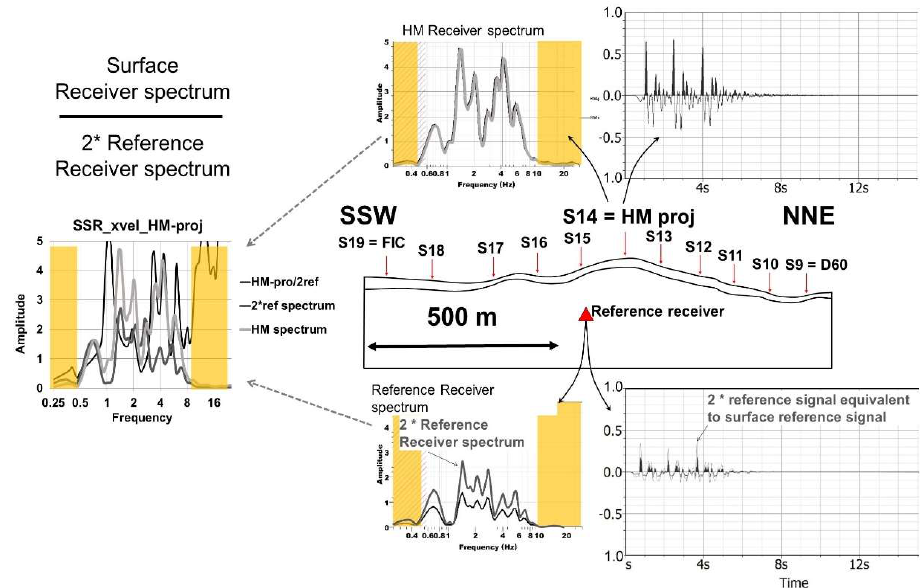
Figure 7. Processing of the modelled site response in terms of standard spectral ratio (SSR in the left graph, in black, together with S14 spectrum in light grey and reference receiver spectrum multiplied by two in dark grey) exemplified for the S14 receiver that corresponds to the equivalent Hotel Montana (HM) site along the 2D section (near the hill top). As reference receiver, a subsurface receiver was used, whose response was multiplied by a factor of two (see dashed signal in lower right part of the figure, as well as the doubled spectrum amplitudes in grey) to represent the one of a rock surface receiver in the same model. See also parts of spectrum with low energy content (not used for analysis) marked by orange semi-transparent mask.